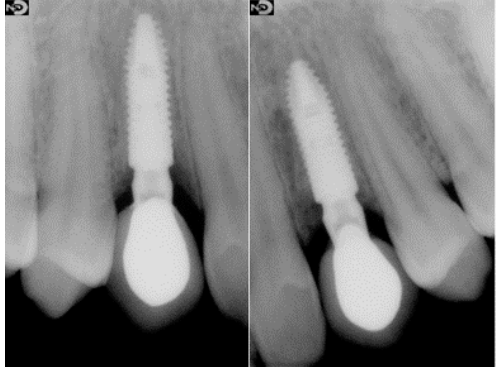
Figure 8. Radiographs of definitive restorations after 2-year follow-up.